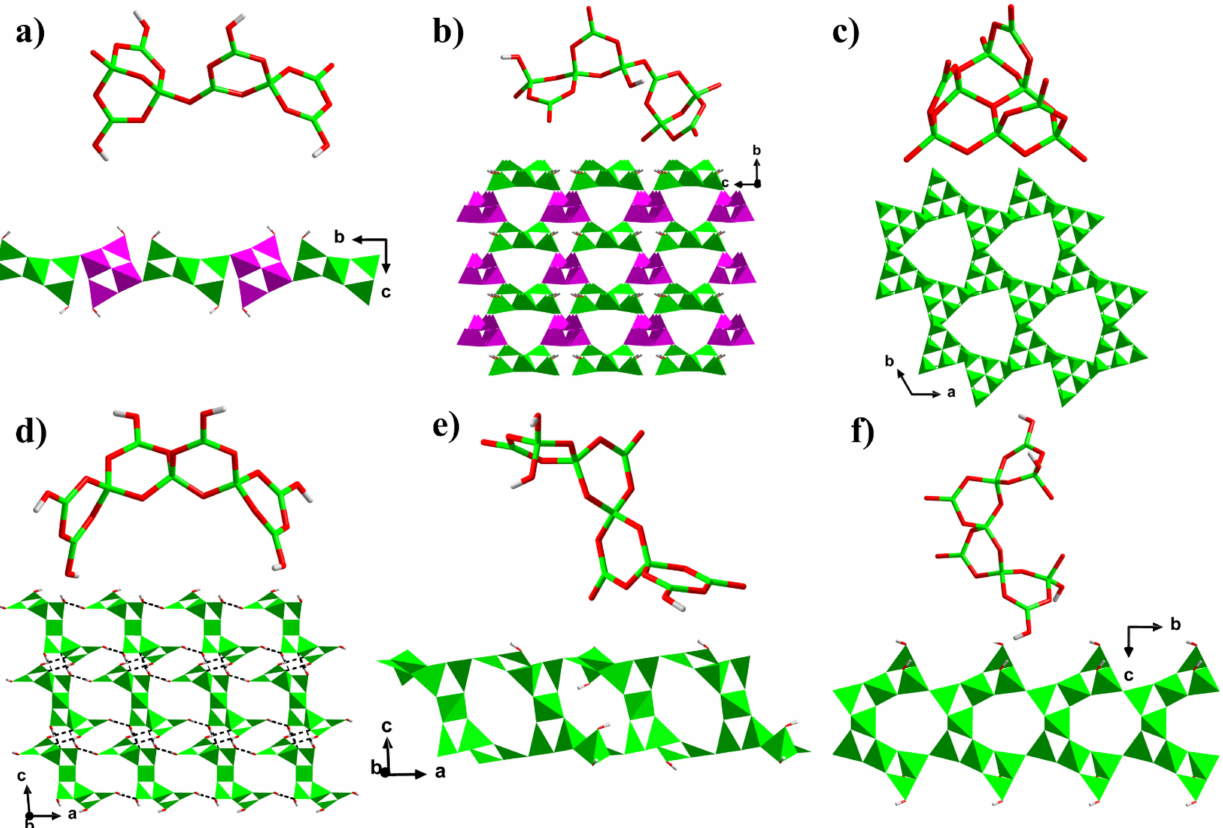
Figure 3. ( a ) [B 9 O 14 (OH) 4 ] 5 − FBB and the 1D chain in Ni(en) 3 · Hen · [B 9 O 13 (OH) 4 ] · H 2 O. ( b ) [B 9 O 18 (OH) 2 ] 11 − FBB and the 3D diamond framework in Li 2 [B 4 O 7 ][B 5 O 8 (OH) 2 ]. ( c ) [B 9 O 19 ] 11 − FBB and the 3D acs framework in LiBa 3 (OH)[B 9 O 16 ][B(OH) 4 ]. ( d ) [B 9 O 12 (OH) 6 ] 3 − FBB and the 3D supramolecular framework in [C(NH 2 ) 3 ] 3 [B 9 O 12 (OH) 6 ]. ( e ) [B 9 O 16 (OH) 3 ] 8 − FBB and the 1D zigzag belt in Na 4 [B 9 O 14 (OH) 3 ] · 0.5H 2 O. ( f ) [B 9 O 16 (OH) 4 ] 9 − FBB and the 1D linear belt in Na 5 [B 9 O 14 (OH) 4